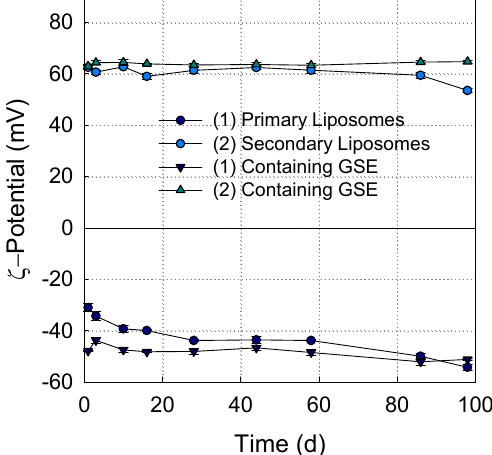
Figure 3. ζ -potential of (1) primary liposomes and (2) secondary liposomes with and